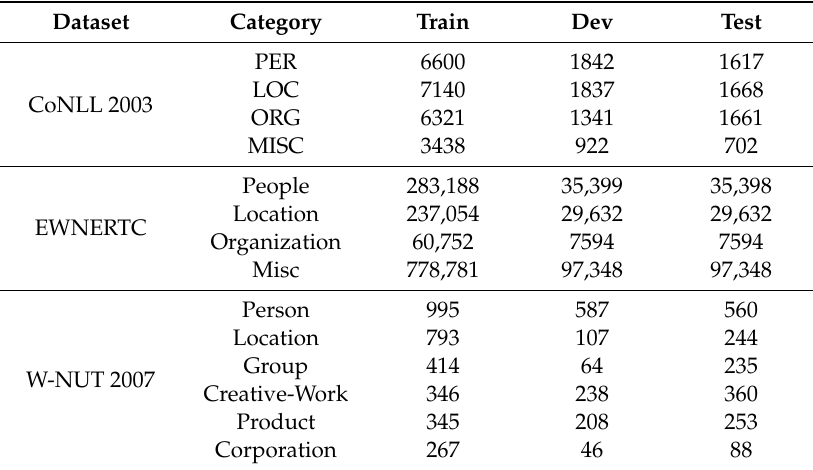
Table 1. Statistics of named entity recognition (NER)